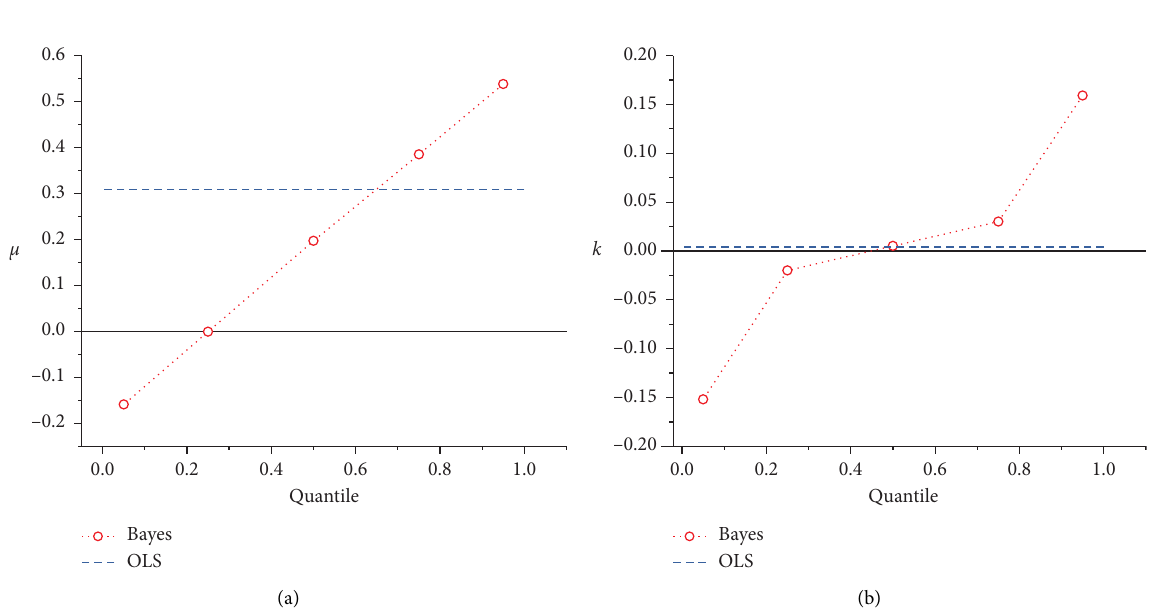
Figure 8: Quantile plots for the (a) curvature friction coefficient and (b) wobble friction coefficient. Dotted lines represent the OLS estimate.